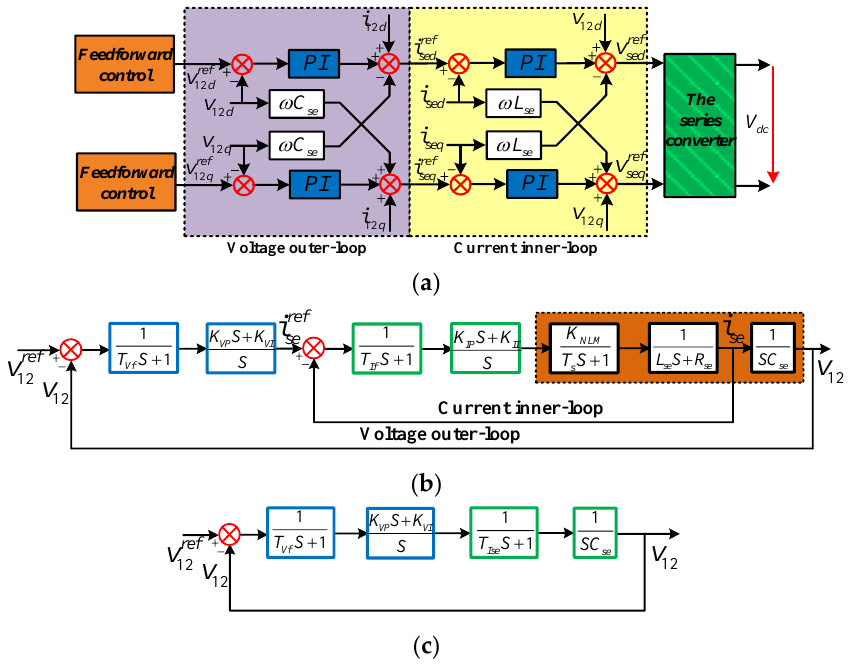
Figure 16. Diagrams of the basic control scheme and loops of the series converter. ( a ) The basic control scheme; ( b ) The initial double control loops; ( c ) The simplified unity-feedback control loop.